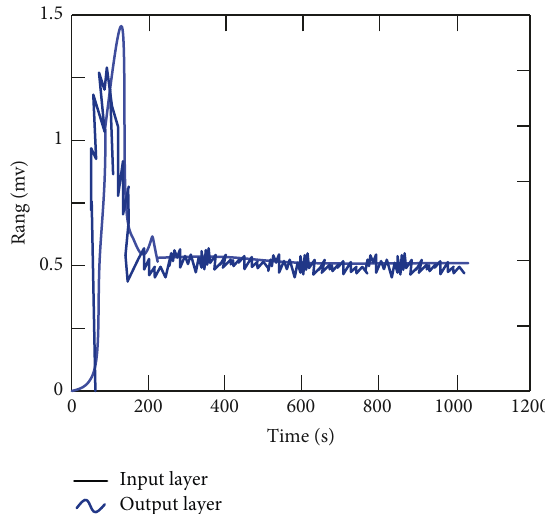
Figure 11: Digital shaping simulation of nuclear engineering cost data